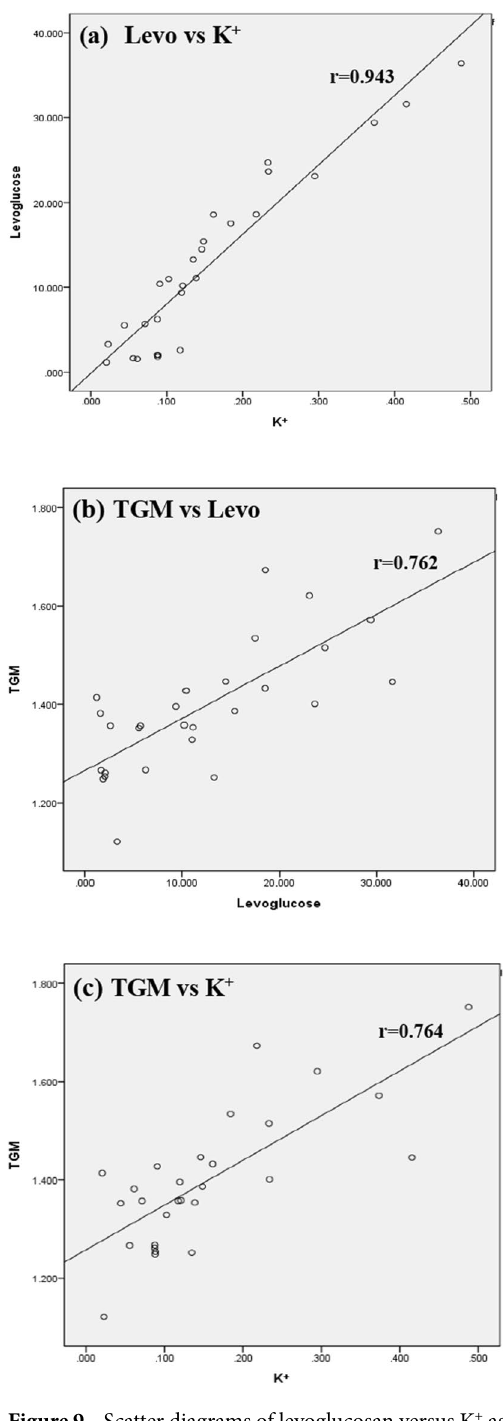
Figure 9. Scatter diagrams of levoglucosan versus K + as well as TGM versus levoglucosan and K + in PM 2.5 at the Taiping Island in the South China